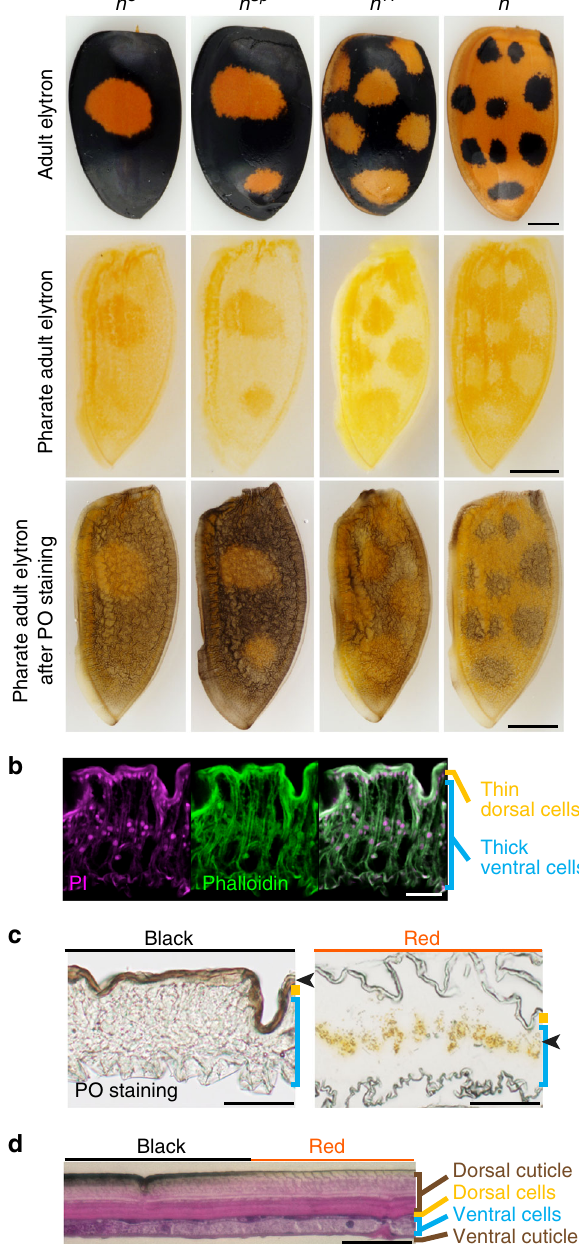
Fig. 2 Developmental programs for elytral pigmentation initiate at the late pupal stage. a Adult elytral colour patterns (upper panels), and localisation of carotenoid (middle panels, orange) and phenol oxidase (PO) activity (lower panels, black) in pharate adult elytra at 96 h AP. Proximal is up. Outer rims are to the left. b – d Cross sections of elytra at 96 h AP ( b , c ) and adult ( d ). Dorsal is up. b magenta, nuclei (propidium iodide); green, F-actin (phalloidin). c left, PO staining; right, No staining. Arrowheads indicate pigmented areas. d Haematoxylin and eosin staining. Scale bars, 1 mm in ( a ), 50 μ m in ( b – d